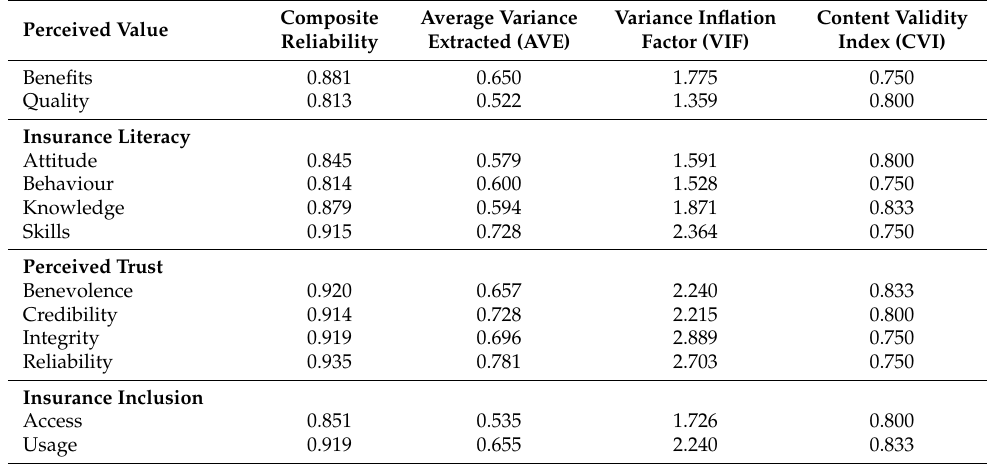
Table 1. Composite reliability, construct validity, multicollinearity and content validity.